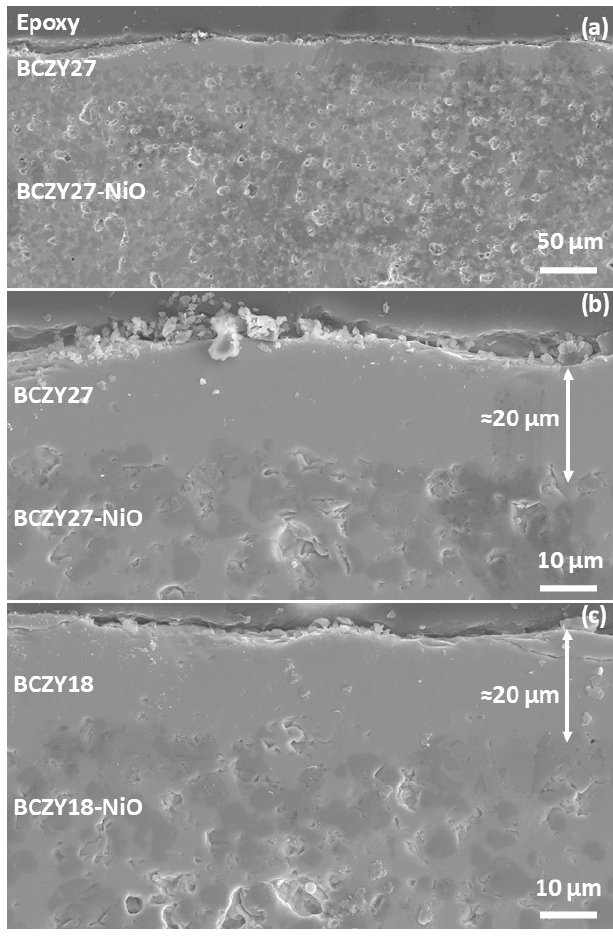
Figure 3. Secondary electron micrographs of a polished cross-section of ( a , b ) a co-sintered BCZY27- NiO/BCZY27 tube and ( c ) a co-sintered BCZY18-NiO/BCZY18 tube. A top view of the BCZY27-NiO/BCZY27 tube is reported in Figure 4 to confirm the well-sintered microstructure of the electrolyte.